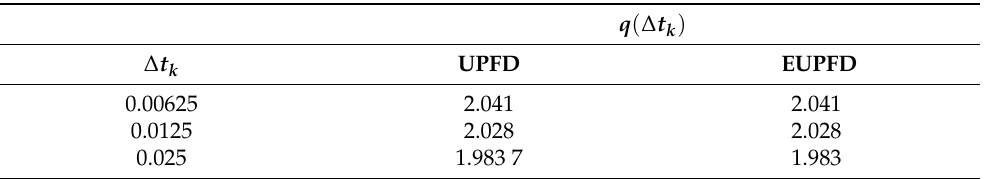
Table 5. Convergence rates for the nonlinear diffusion reaction by the UPFD and EUPFD equations with respect to ∆ t and a fixed ∆ x = 0.01.